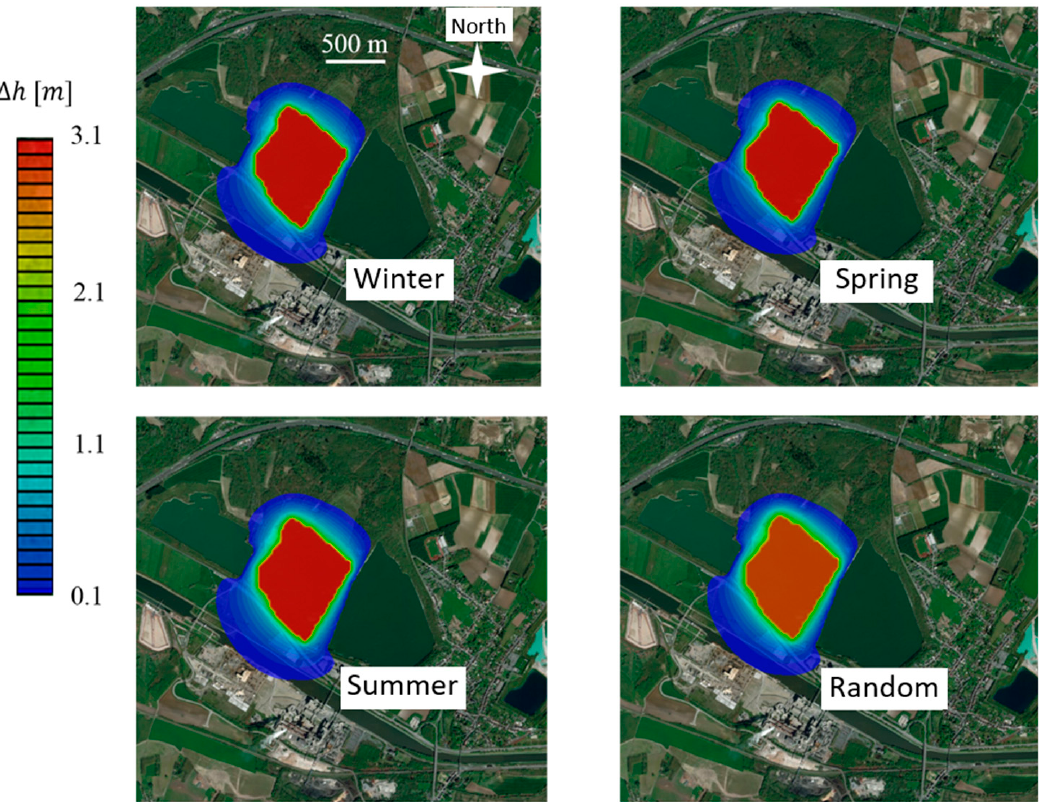
Figure 7. Zone of influence of pumping–discharge operations around the Obourg quarry at the end of the simulation time (14 days). A threshold of 0.1 m for piezometric head variations was assumed to delimitate the area of influence. If piezometric head fluctuations were lower than this threshold, it was considered as outside the zone of influence of PSH operations in the aquifer.